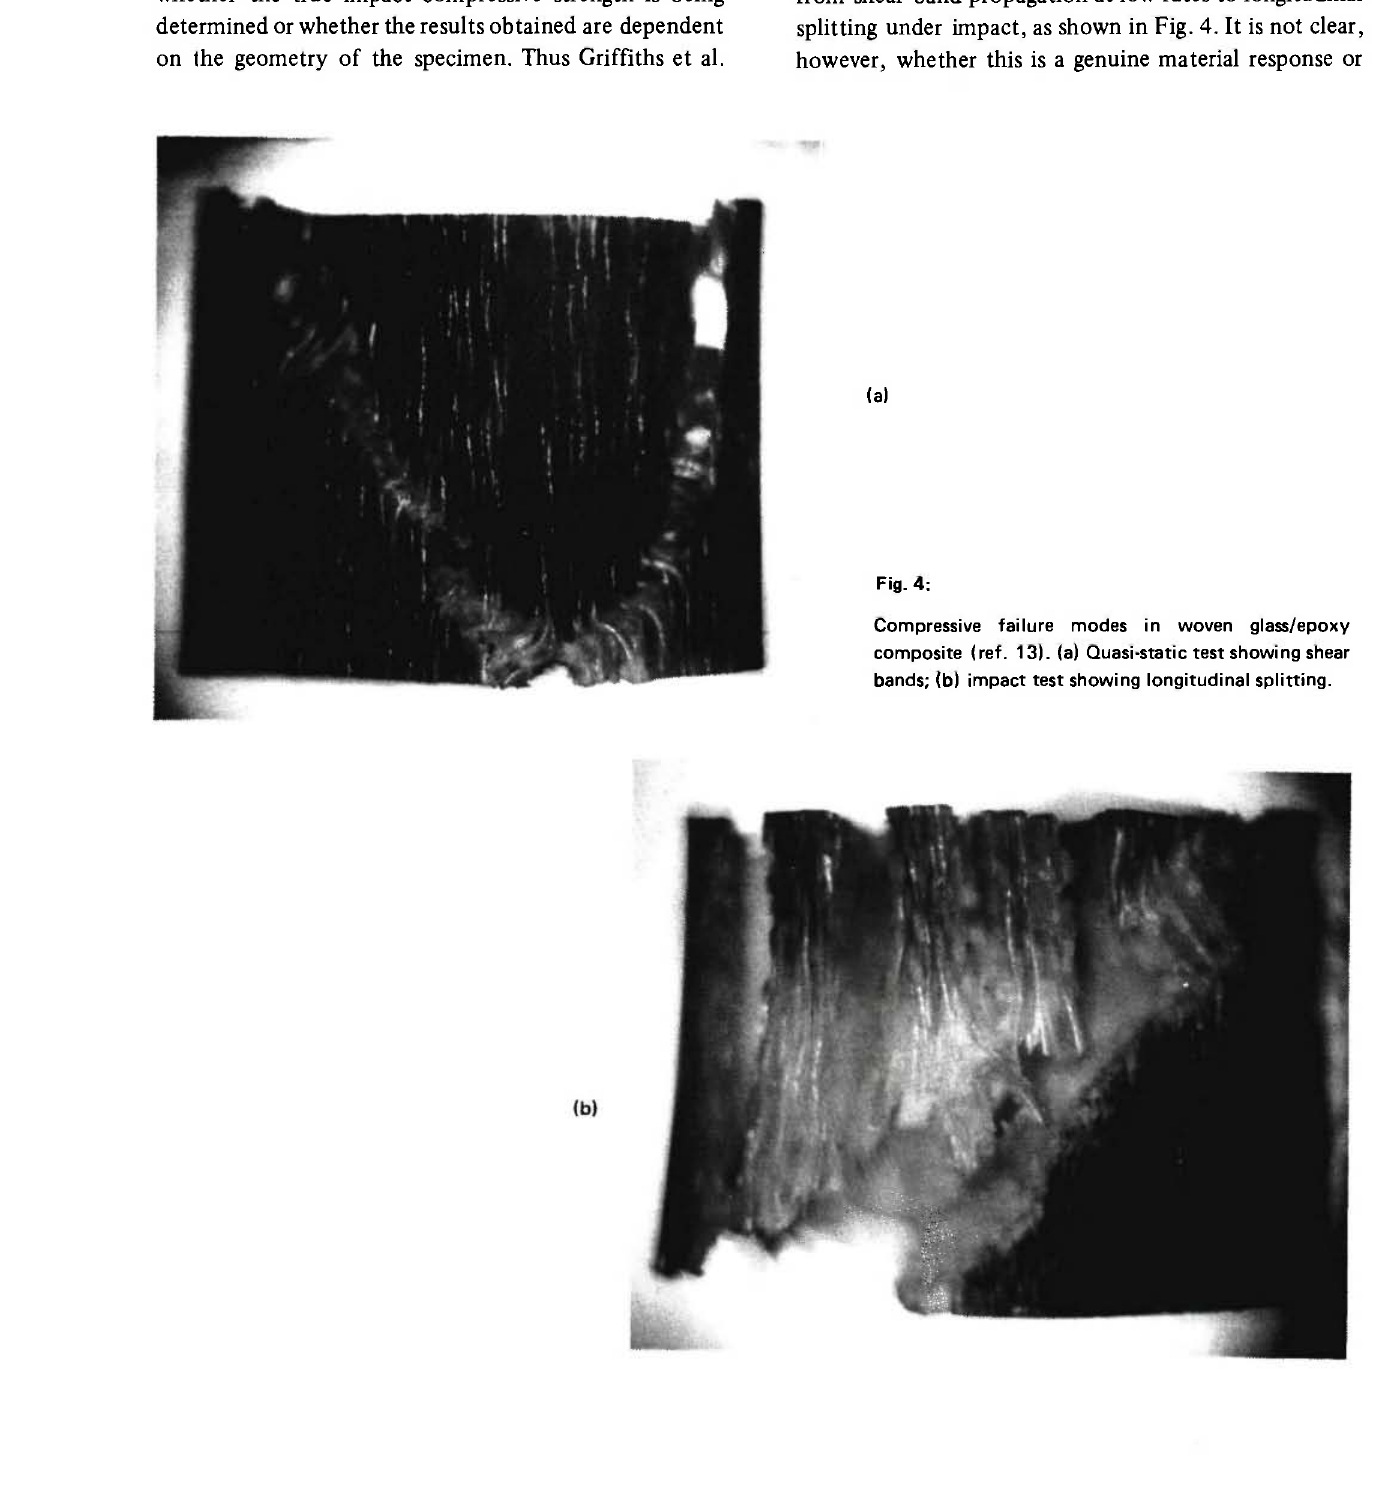
Compressive failure modes in woven glass/epoxy composite (ref. 13). (a) Quasi-static test showing shear bands; (b) impact test showing longitudinal